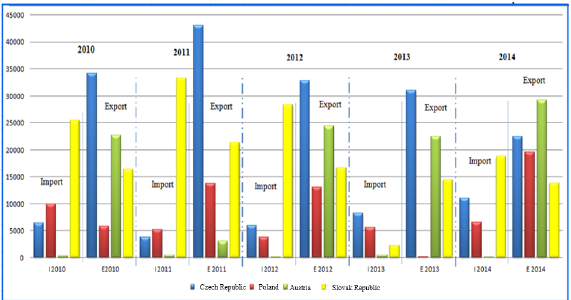
Figure 1: Import and Export of chosen countries, 2010–2014 in thou- sands